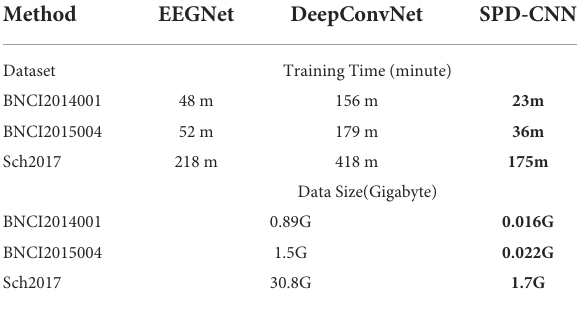
TABLE 5 The time complexity and scale of the dataset for different networks are compared in this